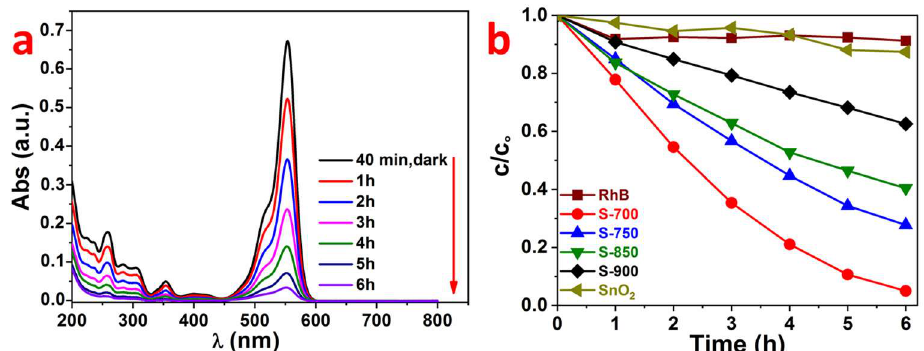
Figure 9. ( a ) UV-Vis spectra for the degradation of rhodamine B (RhB) under visible light irradiation ( λ ≥ 420 nm) on the LaFeO 3 S-700 sample ([RhB] = 10 − 5 M, catalyst weight = 0.1 g) at 25 ◦ C. ( b ) Degradation of RhB as a function of irradiation time with visible light ( λ ≥ 420 nm) in the presence of different LaFeO 3 catalysts or SnO 2 for comparison.